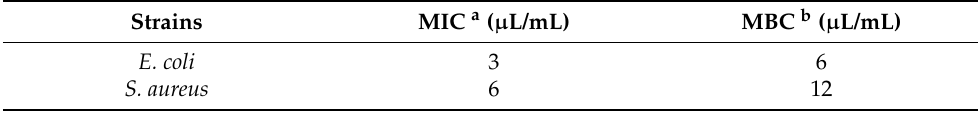
Table 3. The MIC and MBC of the AgEo on E. coli and S.